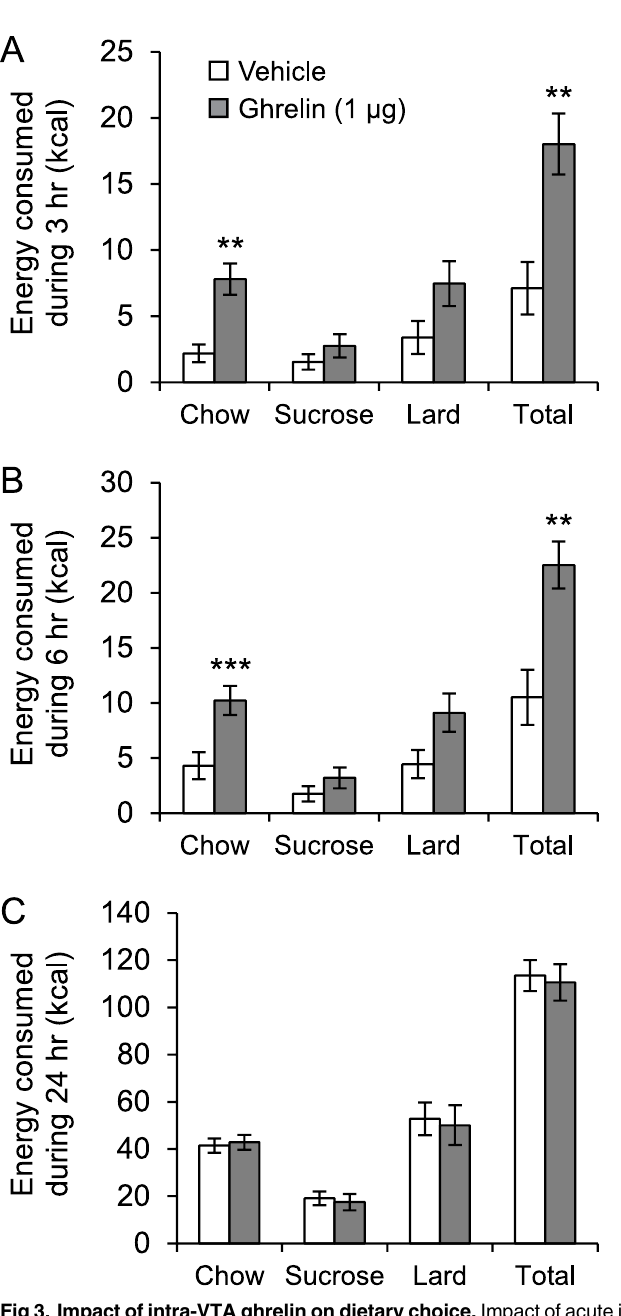
Fig 3. Impact of intra-VTA ghrelin on dietary choice. Impact of acute intra-VTA (ventral tegmental area) injection of ghrelin on total energy intake and dietary choice during (A) 3 hr, (B) 6 hr and (C) 24 hr, in rats (n = 17) that had been ad libitum fed a choice diet comprising normal chow, 1 g sucrose pellets and lard (saturated animal fat) over the previous 14 days. All rats received ghrelin and vehicle solution in a cross over design with one day washout between injections. ** P < 0.01, *** P < 0.001.